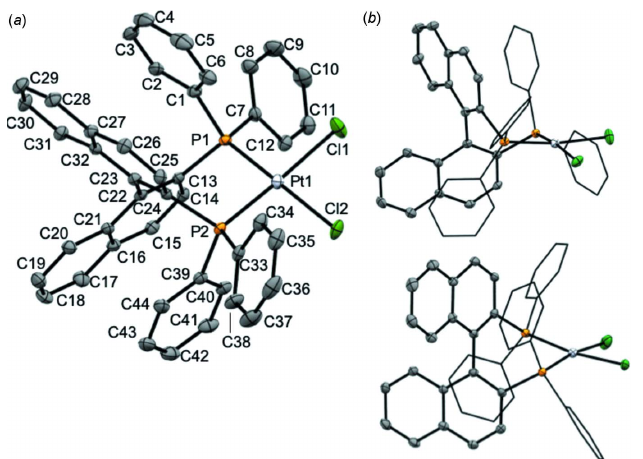
Figure 3 Solid-state structure of (BINAP)PtCl 2 showing ( a ) fully atom labels of the R enantiomer and ( b ) side-on views of both R and S atropisomers present the crystal structure. Displacement ellipsoids are shown at the 50% probability. Hydrogen atoms and co-crystallized acetonitrile solvent molecules are omitted for clarity.